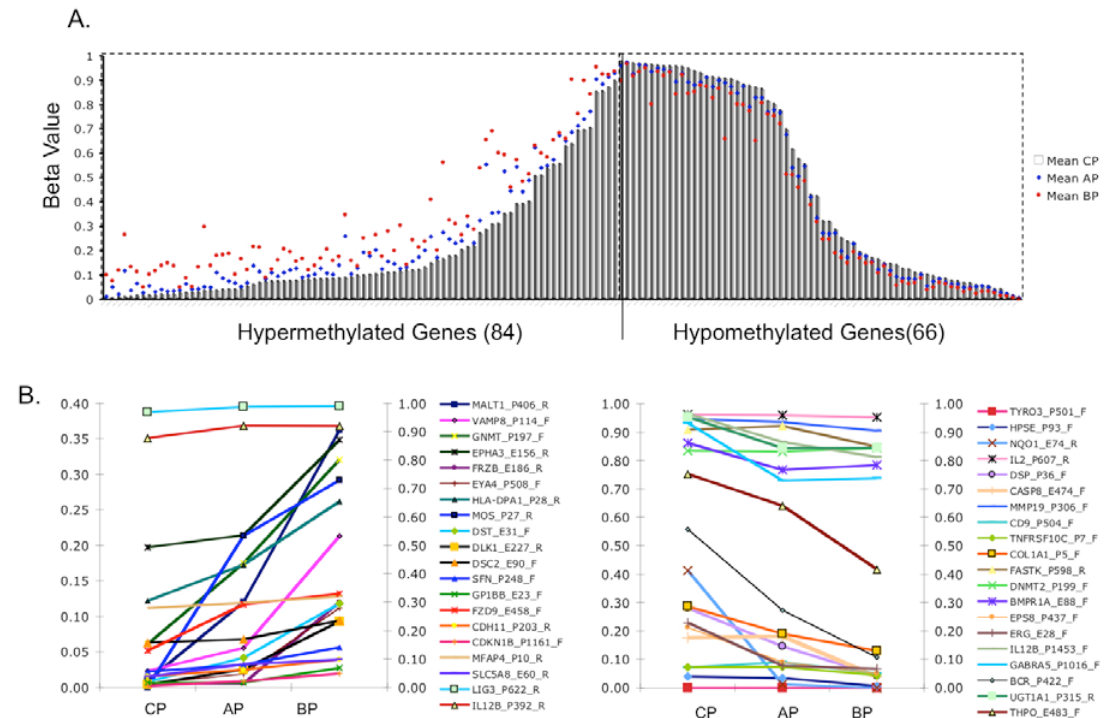
Figure 5: DNA methylation changes associated with CML progression. (A) DNA methylation levels at 84 loci showed a significant increase while 66 loci showed a significant decrease during progression of CML from chronic phase (bars) to accelerated phase (blue dots), and blast crisis phase (red dots). (B) Examination of 20 hypermethylated (left) and 20 hypomethylated (right) CML progression related loci with serial samples from a single